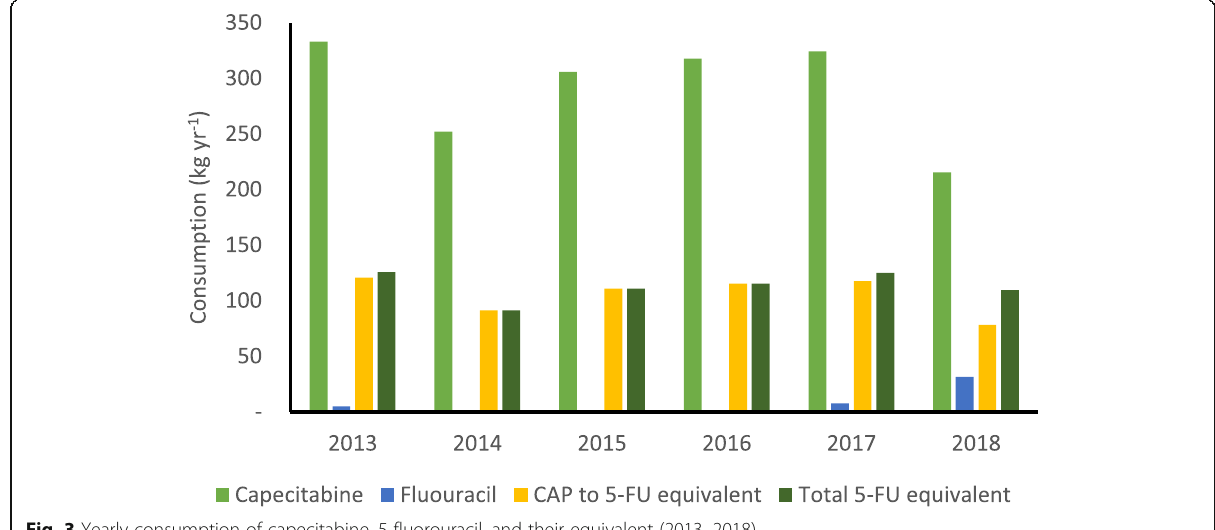
Fig. 3 Yearly consumption of capecitabine, 5-fluorouracil, and their equivalent (2013 – 2018)